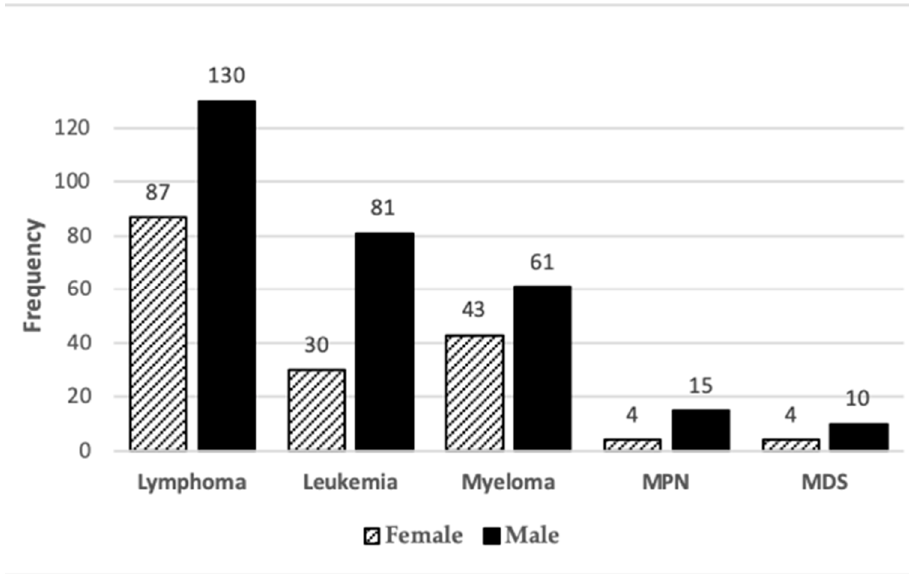
Figure 5. Frequency of cancers of lymphoid and hematopoietic tissue in female and male patients in WTC EHC (MPN = myeloproliferative neoplasms; MDS = myelodysplastic syndromes).